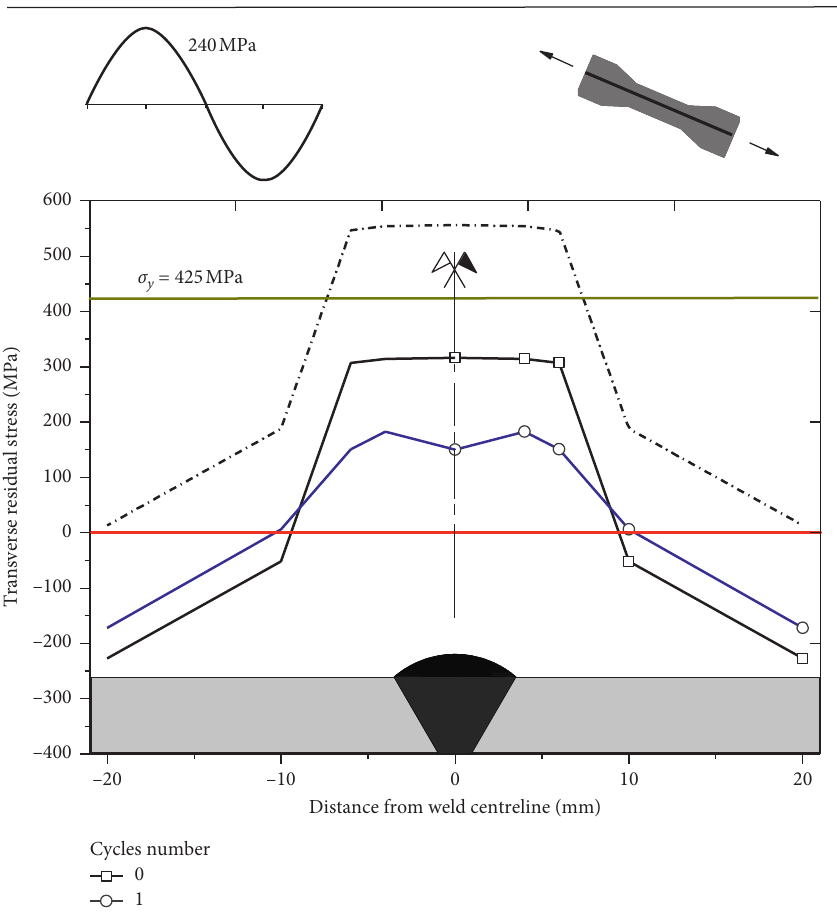
Figure 10: Effect of 240MPa cyclic stress on residual stress relaxation in longitudinal welding.